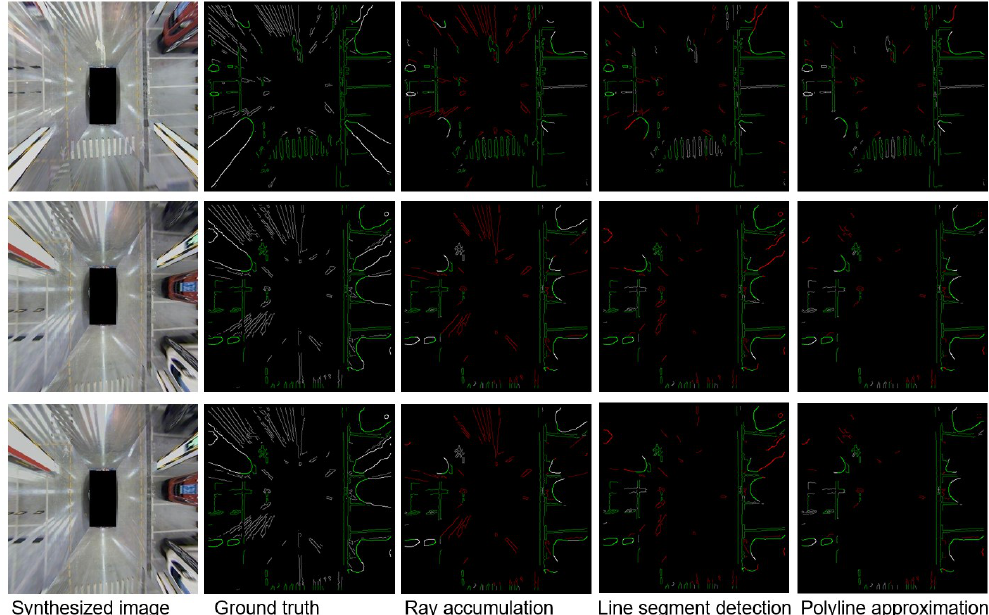
Figure 6. The comparison of different edge segmentation methods. Each row represents the results for different structure extraction methods for the same synthesized image, which is illustrated in the first column, and each column represents the results for different synthesized images with the same structure information extraction method, which is described at the bottom of each column. The first column denotes the three input images, the second column the ground truth of edge information, the third column the edge information extracted by the ray accumulation method, the fourth column the edge information extracted by the line segment detection method, and the fifth column the edge information extracted by polyline approximation method. The manually labeled ground truth edges are drawn in green. For each column of segmented edges, the green lines denote that the edges are correctly preserved, while the red lines denote that the edges are not correctly preserved, and the white lines denote those missed for the specific method. Moreover, The color intensity means whether the edges are inside the free space (brighter) or on the contour of the free space